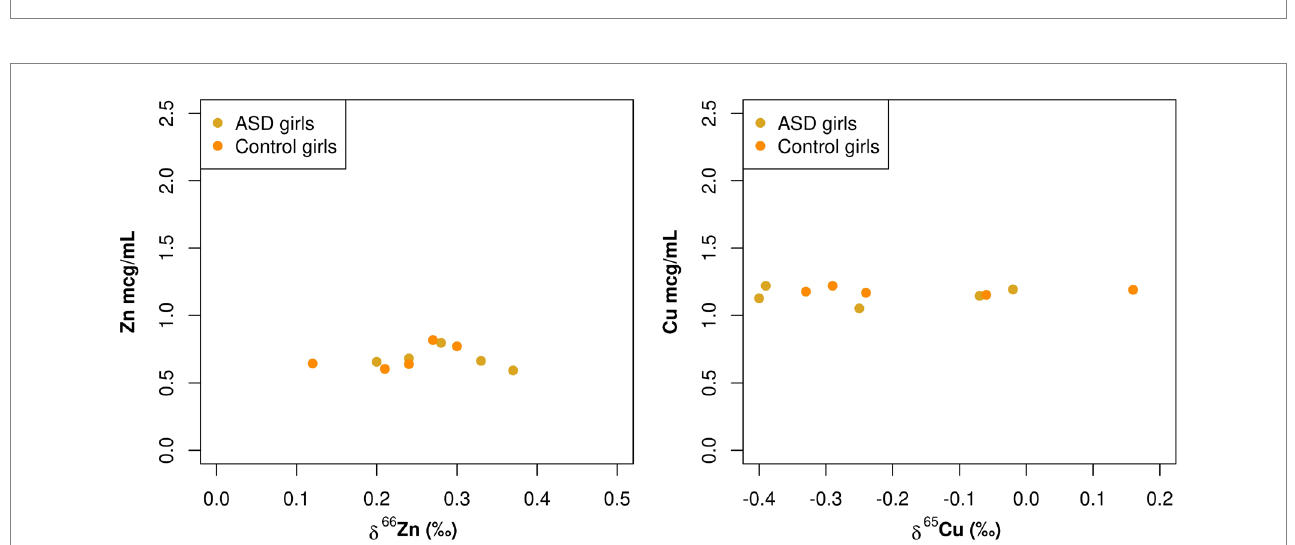
FIGURE 4 Scatterplots comparing the total element concentration of Cu and Zn (mcg/mL) and the isotopic composition δ 65 Cu (‰) and δ 66 Zn (‰) of bulk serum in